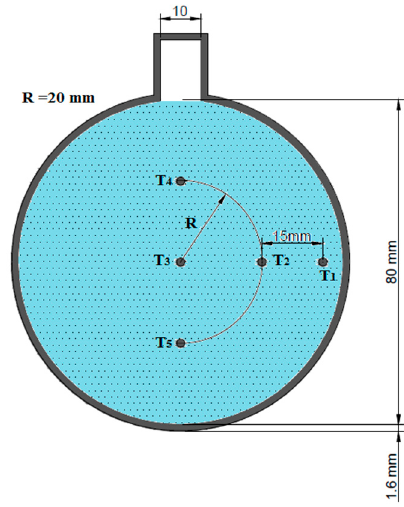
Figure 3. Schematic of the spherical capsule with the locations of the temperature sensors [28].